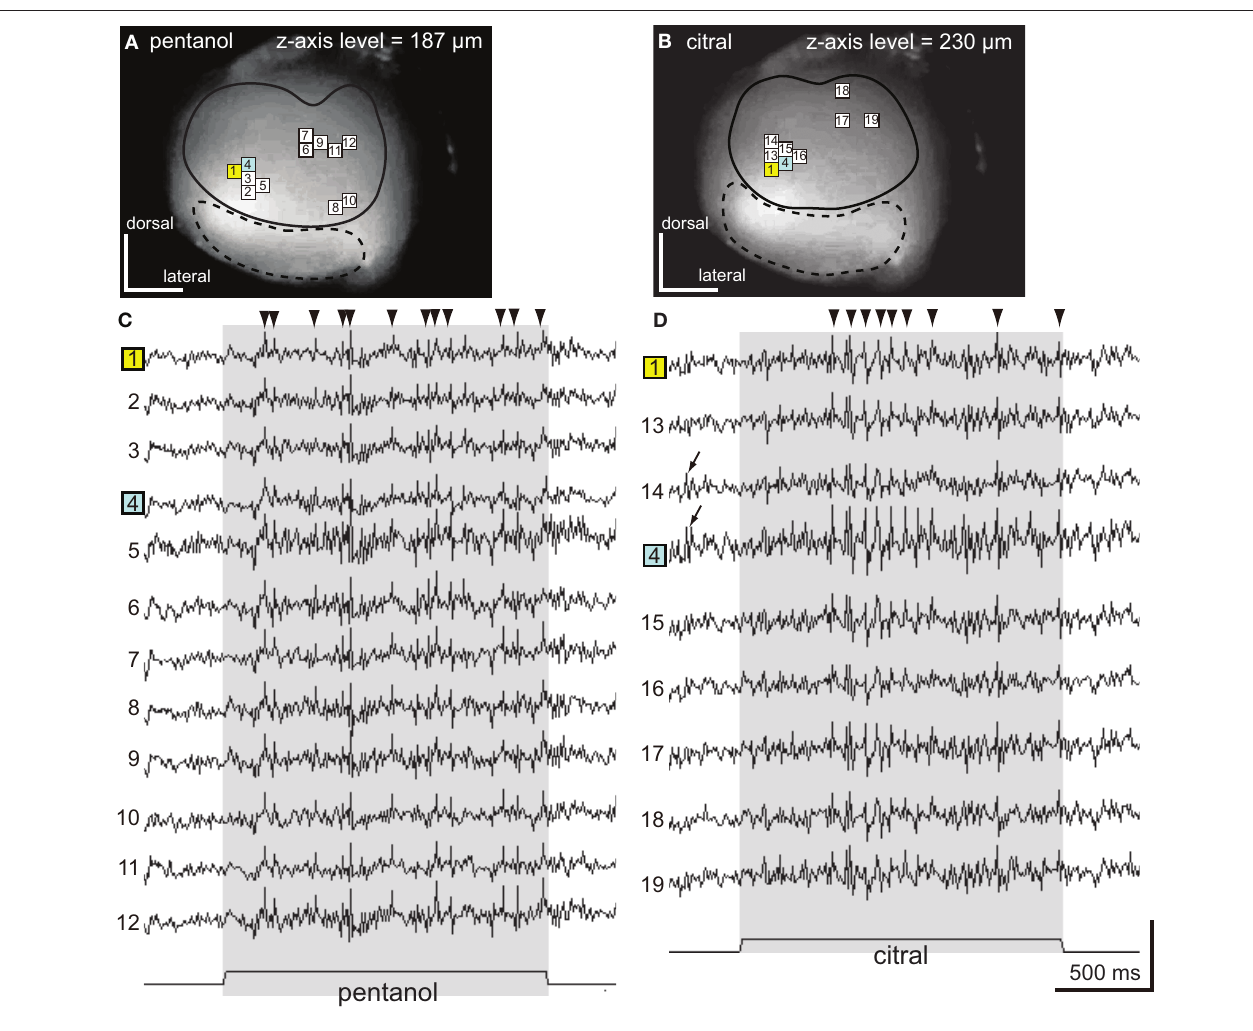
FIGURE 3 | The spatio-temporal patterns of synchronized potentials induced by pentanol and citral. (A,B) VSD images of the cockroach AL. The depolarizing potentials induced by pentanol (A) and citral (B) were observed in 12 (numbers 1–12) and nine pixels (numbers 1, 4, 13–19), respectively, located in the antero-dorsal region of the AL. Areas surrounded by solid and broken lines correspond to the antero-dorsal and postero-ventral glomerular groups, respectively. (C,D) Odor-induced synchronized potentials. The pentanol- (C) and citral-induced (D) depolarizing potentials evoked in the numbered pixels shown on (A) and (B) , respectively. The number 1 (yellow pixel) and 4 (blue pixel) pixels were activated by both pentanol (A,C) and citral